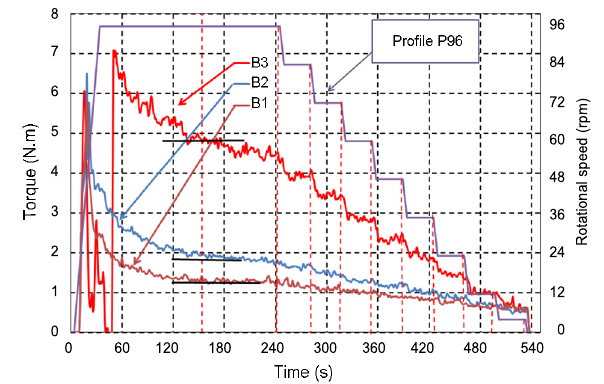
concretesFig. concretesFig. Fig. 6. P48 profile with the three